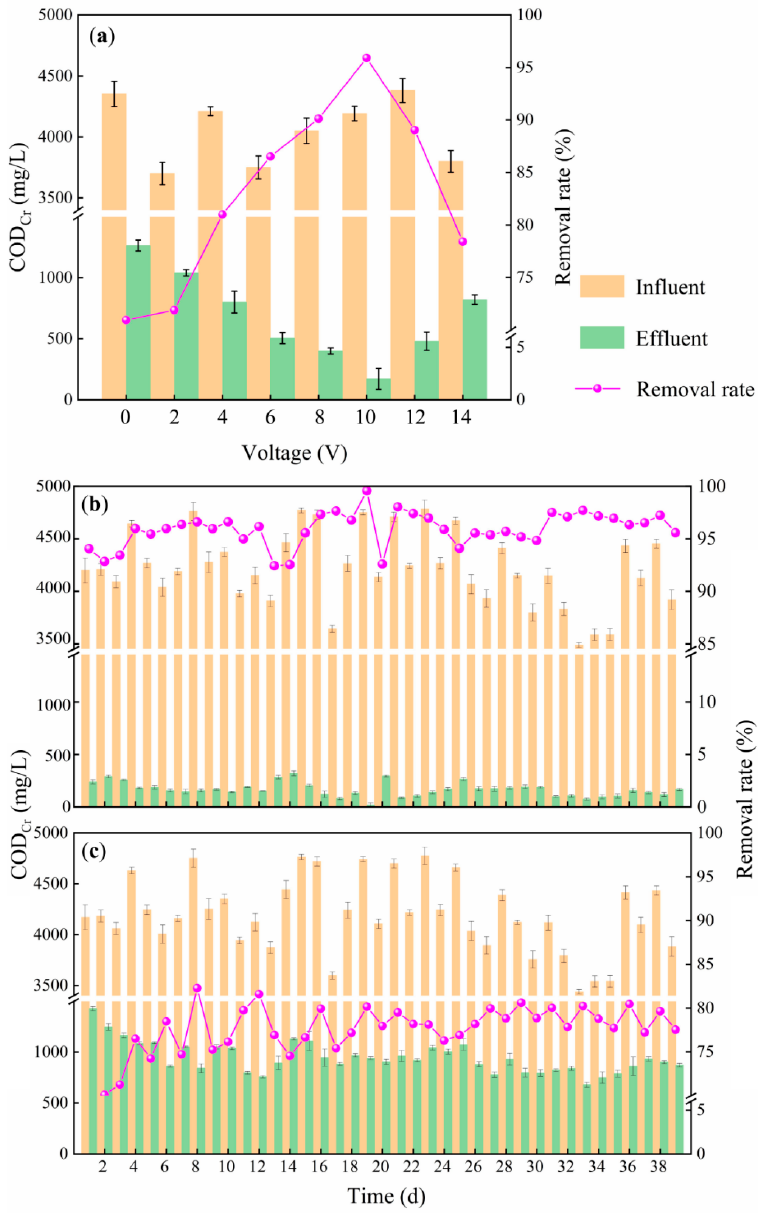
Figure 2. COD Cr removal rate of pharmaceutical wastewater in 3D-BERs ( a ) under different voltages; ( b ) under a voltage of 10 V; and ( c ) under a control group (no power).